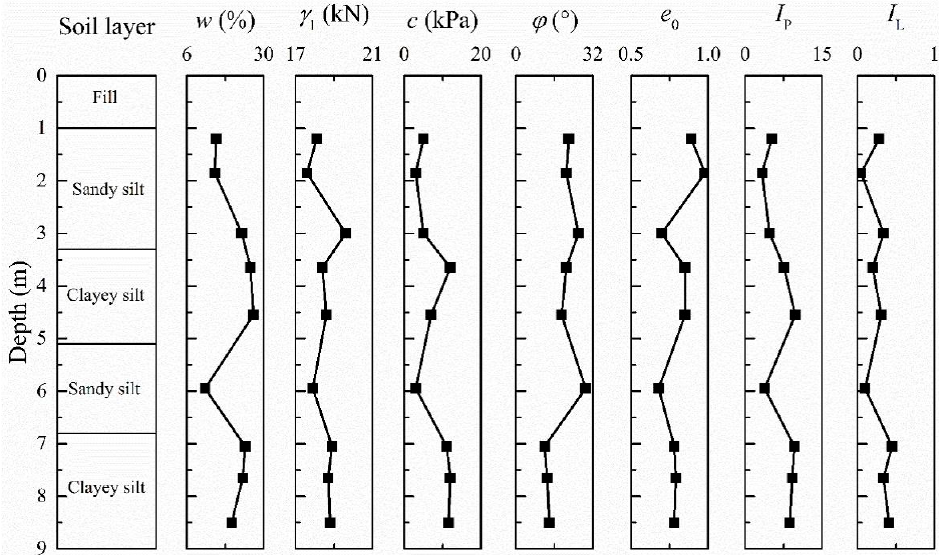
Figure 4. In situ geotechnical profile and soil properties (from left to right: Soil layer, moisture content ( w ), bulk density ( γ l ), cohesion ( c ), angle of internal friction ( φ ), void ratio ( e 0 ), plasticity index ( I p ) and ( w ), bulk density ( γ l ), cohesion ( c ), angle of internal friction ( ϕ ), void ratio ( e 0 ), plasticity index ( I p ) and liquid index ( I L ) varying with depth). liquid index ( I L ) varying with